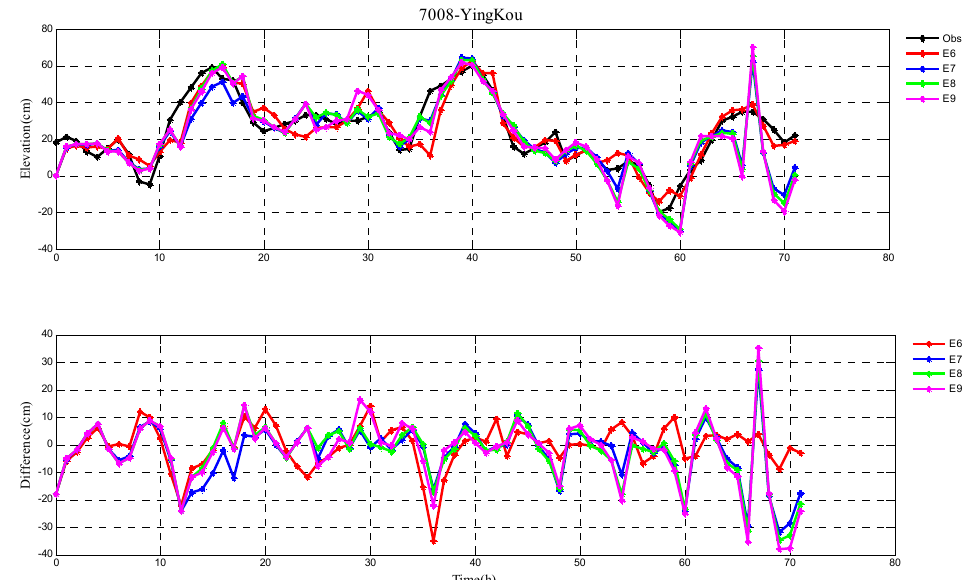
Figure 9. Storm surge elevations in four experiments (E6–E9), observations (black line) ( top ), and